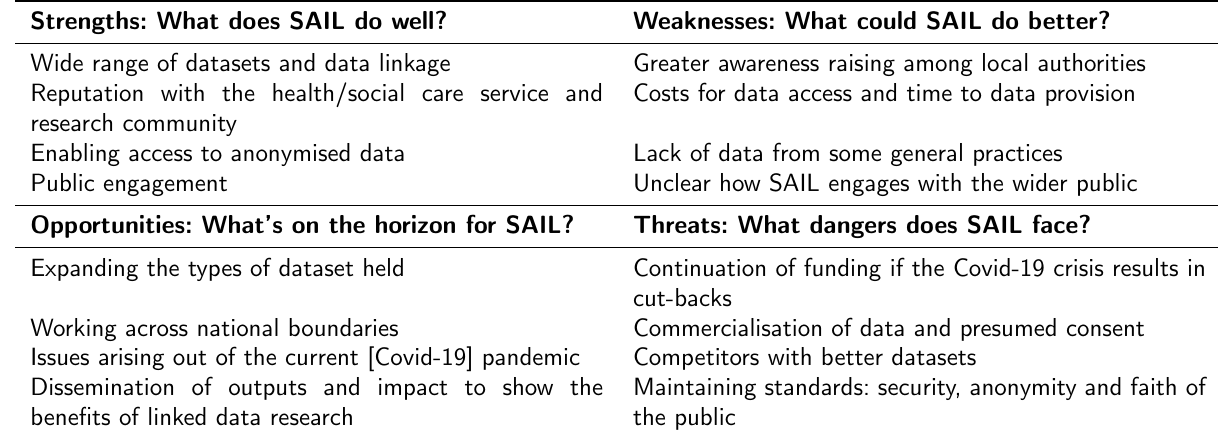
Table 2: Summary of the SWOT analysis with the Consumer